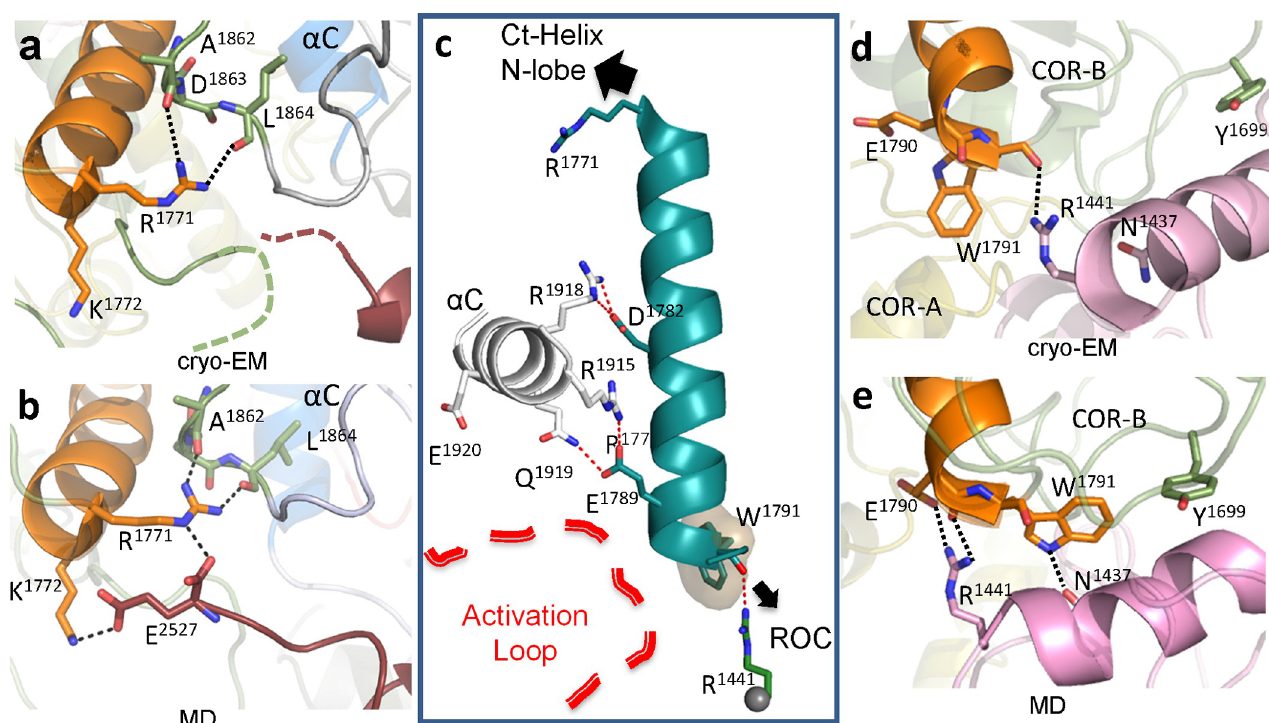
Fig 4. Capturing interactions at the N-and C-termini of the COR-B Helix. (a) The N-terminal end of the COR-B Helix is in close proximity to the C- terminal residues of the Ct-Helix, which are undiscernible in the cryo-EM structure (PDB: 6VNO). (b) GaMD simulations capture the interactions between the COR-B Helix with the COR-B-Kinase linker and with the C-terminal end of the Ct-Helix. (c) In LRRK2 RCKW , the COR-B Helix is stably anchored to the α C helix of the kinase N-lobe. Its N-terminal interacts with the Ct-Helix and the N-lobe of the kinase, while its C-terminal is tethered to the ROC domain and is in close proximity to the A-loop. (d) The C-terminus of the COR-B Helix is anchored to the side chain of R1441 in the ROC domain through W1791. (e) The interaction of E1780 and W1791 with the pathogenic mutation sites R1441 and N1437 on the ROC domain could be captured using GaMD simulations. A- loop, activation loop; cryo-EM, cryogenic electron microscopy; Ct-Helix, C-terminal helix; GaMD, Gaussian accelerated molecular dynamics; MD, molecular dynamics; ROC, ras-of-complex.